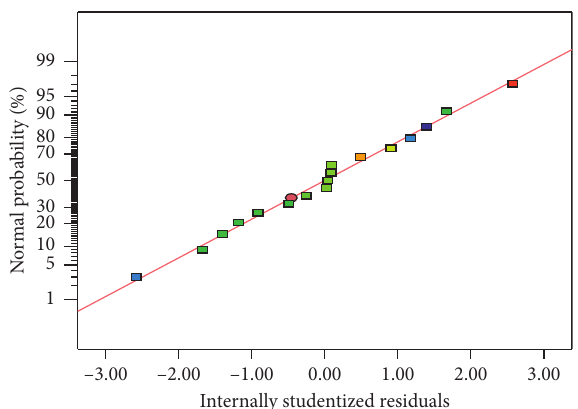
Figure 10: Distribution of the residuals of the combustible